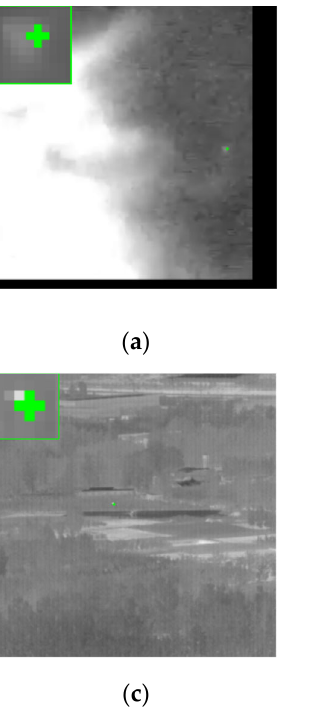
Figure 8. These pictures show the effect of the predicted coordinate tracing points, and it can be seen that the offset of the network prediction results is small and can overlap with the small target. Figure ( a ) is from the SIRST dataset, and its size is less than 256 × 256. To not change the size of the small target in the picture, it is changed to 256 × 256 by padding. Figure ( b – d ) from ground/air background infrared image small aircraft target detection tracking dataset. Table 1 shows the results of the ablation experimental measurements, and the values representing the best performance are indicated in bolded font. For better quantitative analysis, we extracted three thresholds to create the table, with thresholds of 0.5, 0.75, and 0.95. Table 1. The table shows the results of the ablation experiment, where the threshold indicates the different OKS thresholds, the corresponding value is the proportion of the number of test samples satisfying the threshold to the total number of test samples, and accuracy rate indicates the ratio of the number of test samples with the distance between the predicted coordinates and the real coor ‐ dinates to the number of test samples with the radius of the inner tangent circle of the target ground truth less than 1.